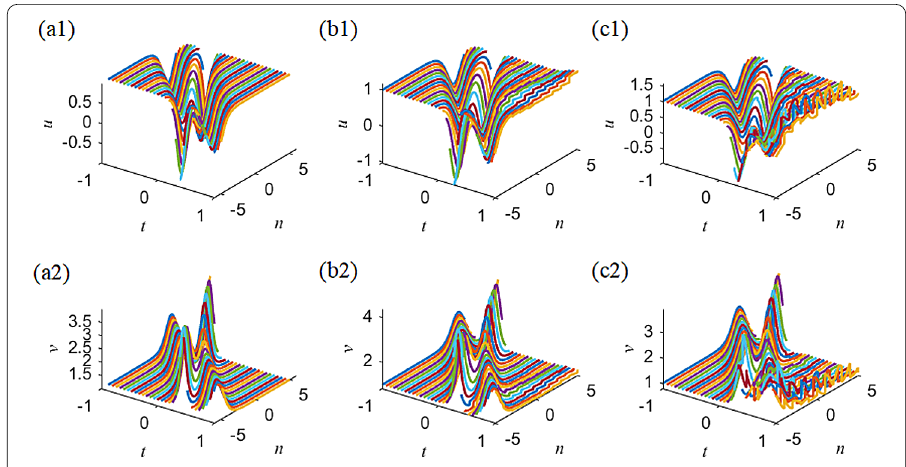
Figure 10 Collisions of two-soliton solutions (cid:8) u n and (cid:8) v n in (50) with N = 1 via the parameters r 1 = –1, r 2 = 1, λ